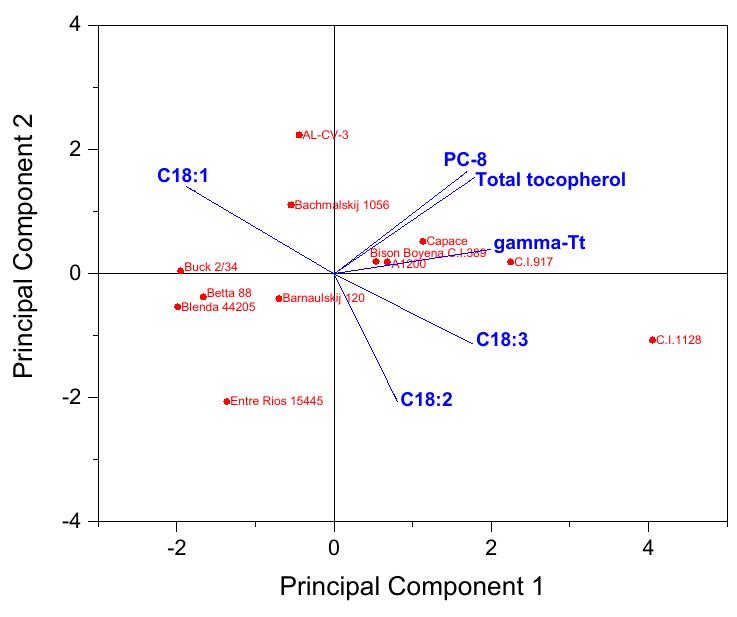
Fig. 6 Biplot representation of PCA for worldwide accessions of flax (Group